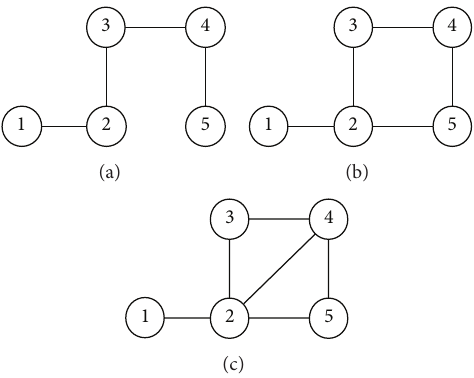
Figure 1: Three small